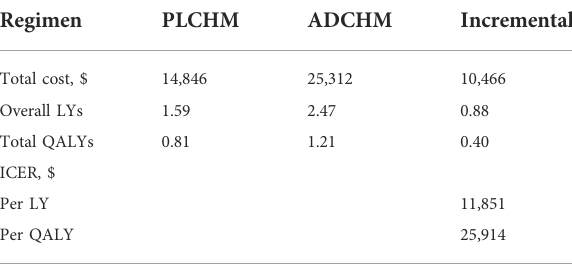
ADCHM: adebrelimab in combination with chemotherapy (etoposide-carboplatin); ICER: incremental cost-effectiveness ratio; LY: life year; PLCHM: placebo plus chemotherapy (etoposide-carboplatin); QALY: quality-adjusted life